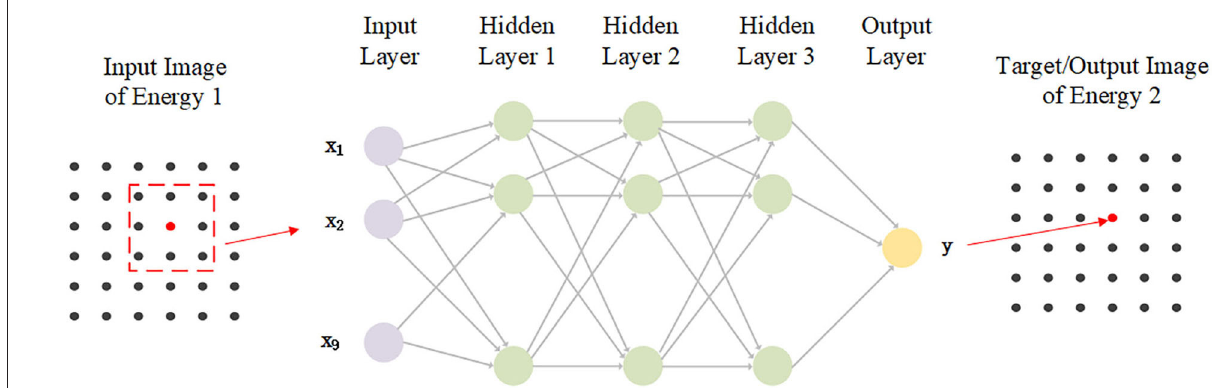
FIGURE 5 | The structure of the fully connected network.